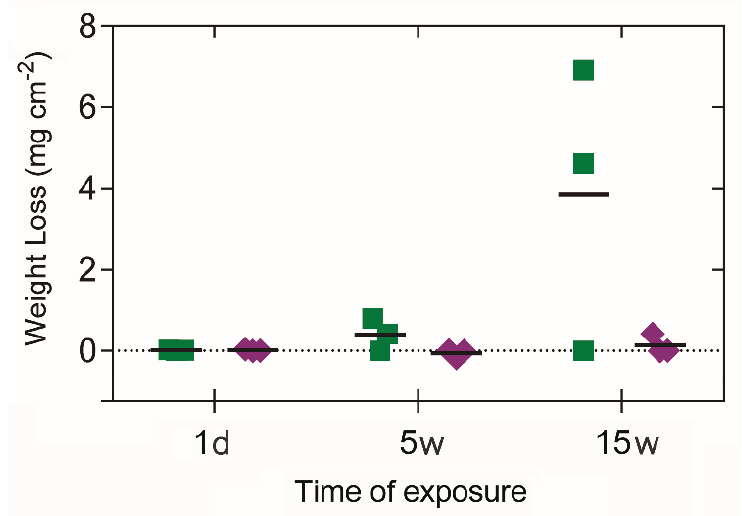
Table 1. Electrochemical and deterioration analysis of stainless steel 316L after exposure to natural seawater.